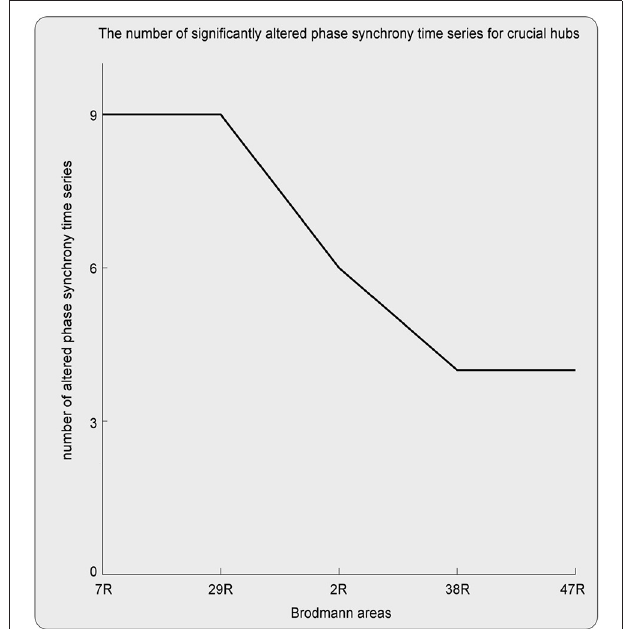
FIGURE 5 | The crucial hubs (i.e., the ROIs with more than four aberrant TV-PS time series) and the number of significantly altered TV-PS time series for these crucial hubs.